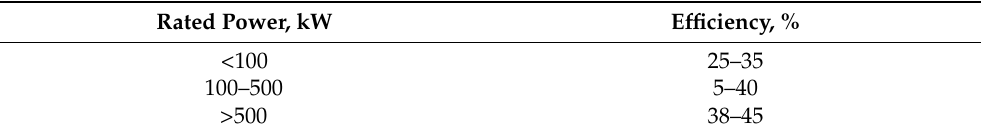
Table 2. Electrical efficiency of CHP [32].